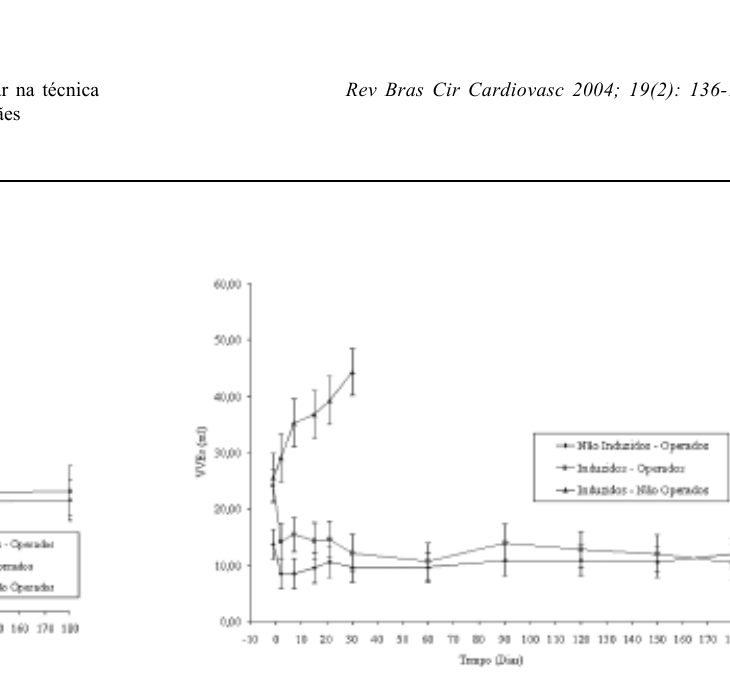
Fig. 5 – Volume do ventrículo esquerdo em sístole (VVEs – ml), ao longo do tempo, de cães hígidos (n=5) ou com cardiomiopatia dilatada induzida pela doxorrubicina (n=4), submetidos à plicatura da parede livre do ventrículo esquerdo e cães induzidos não operados